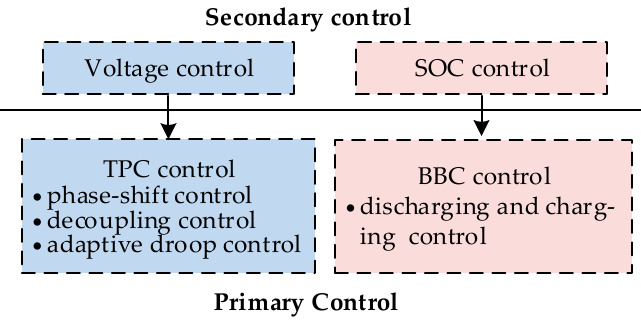
Figure 7. Structure of the proposed distributed cooperative control.